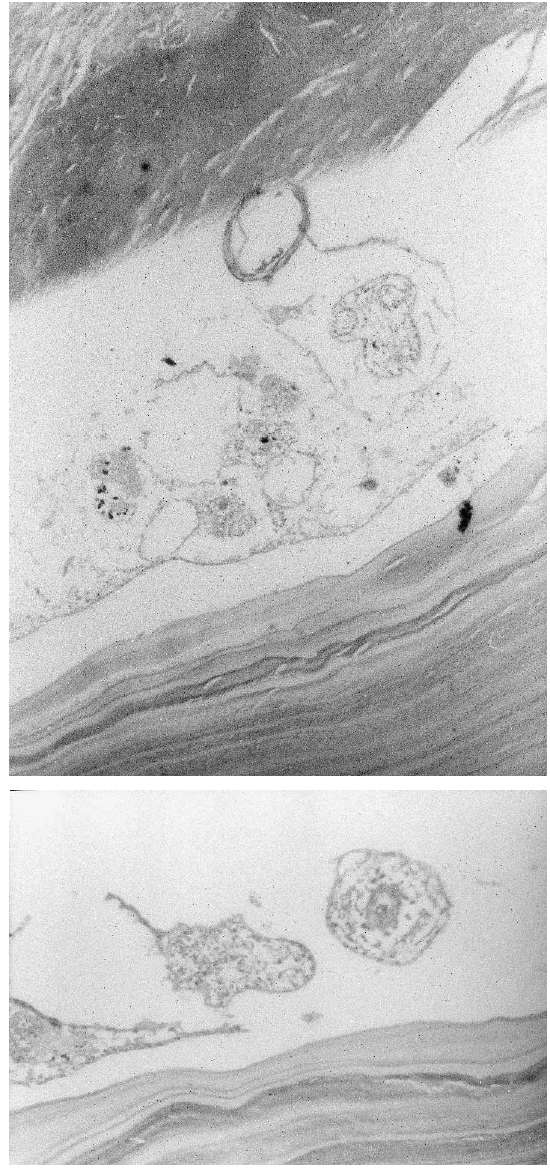
Figure 3 Microphotograph of the lesion reveals lami- nated membrane and the scolices surrounded by fibrous capsule and atrophic